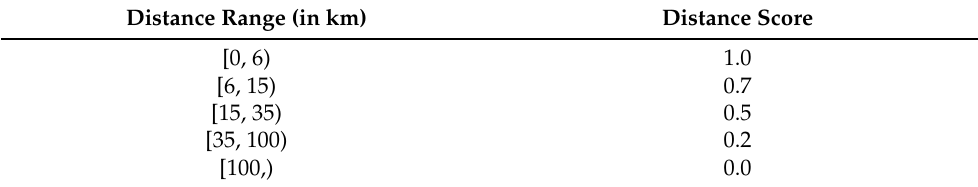
Table 11. Distance